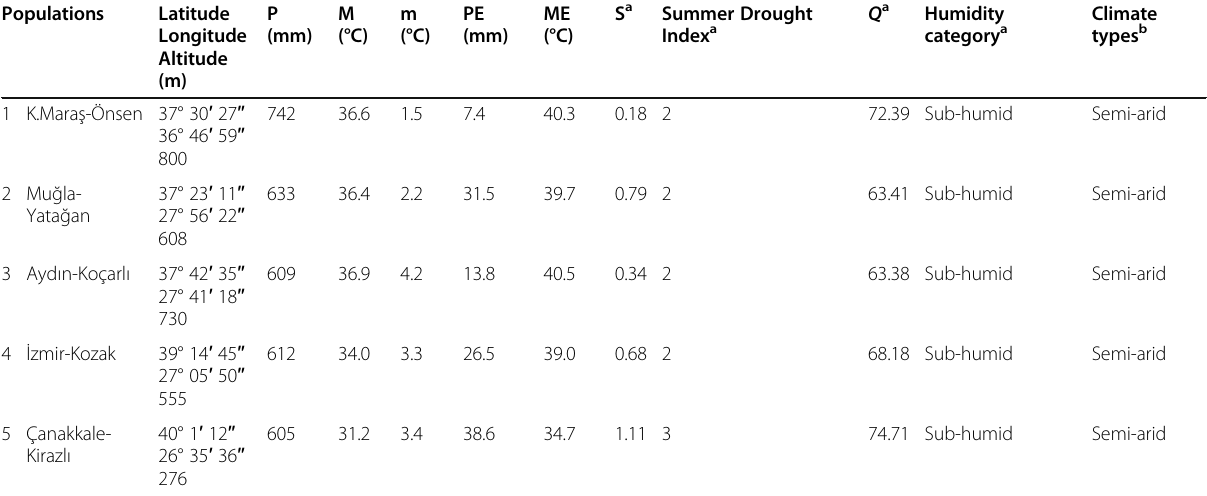
Table 1 Some geographical and climatic characteristics of the five stone pine ( Pinus pinea ) populations across their natural distribution in